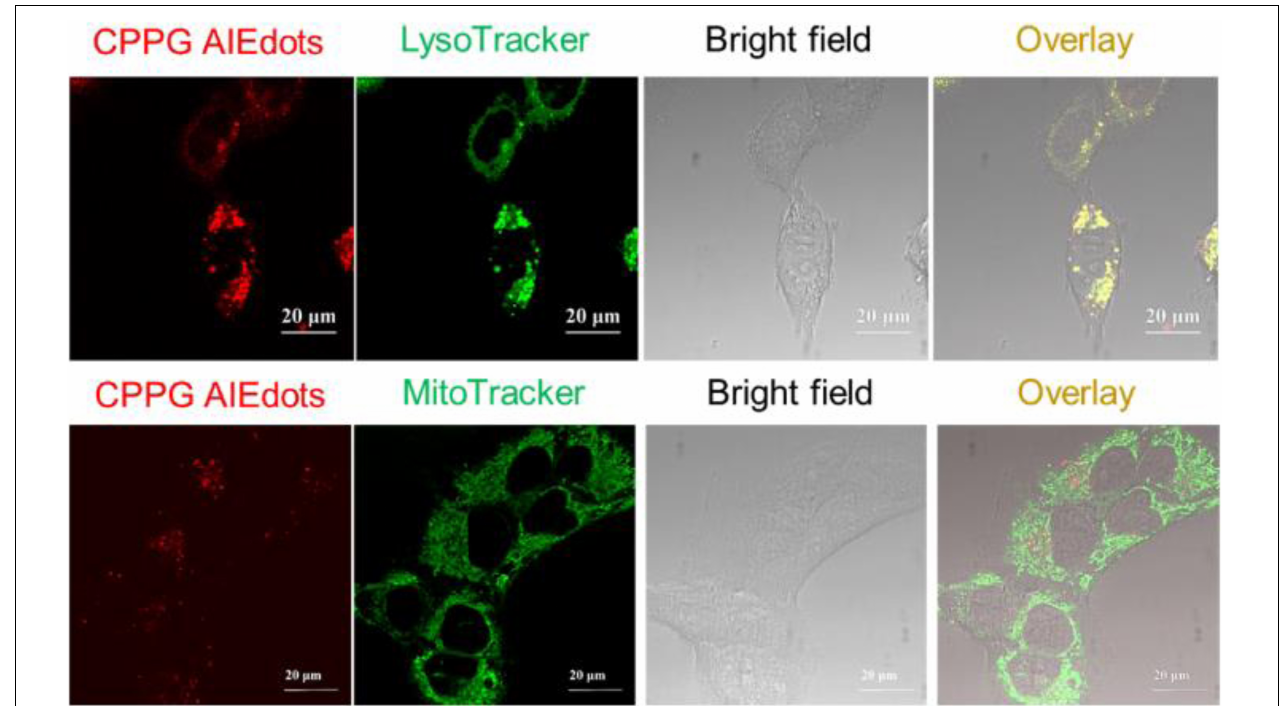
FIGURE 3 | Colocalization studies of CPPG AIE dots with LysoTracker Green DND-99 or MitoTracker Green FM in MCF7 cells, respectively.